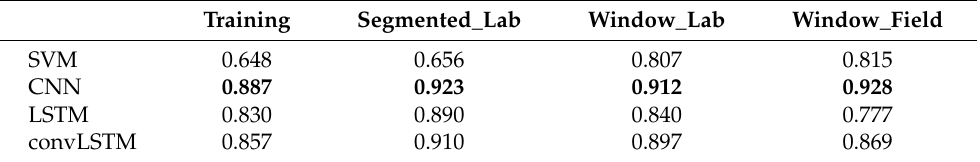
Table 10. Results of the shot and pass classification. The table reports the weighted f1-score for